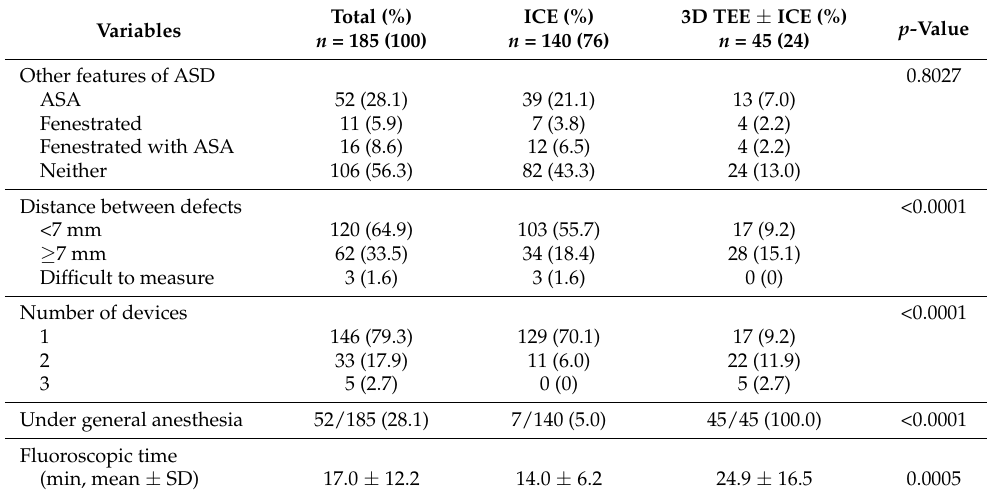
Table 2. Procedural data of the patients who underwent transcatheter device